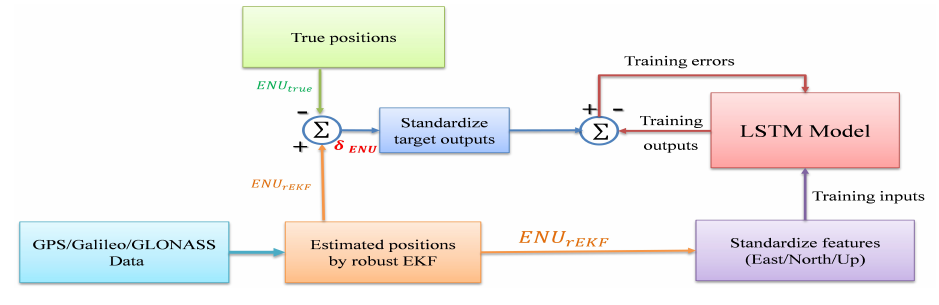
Figure 10. rEKF-LSTM training